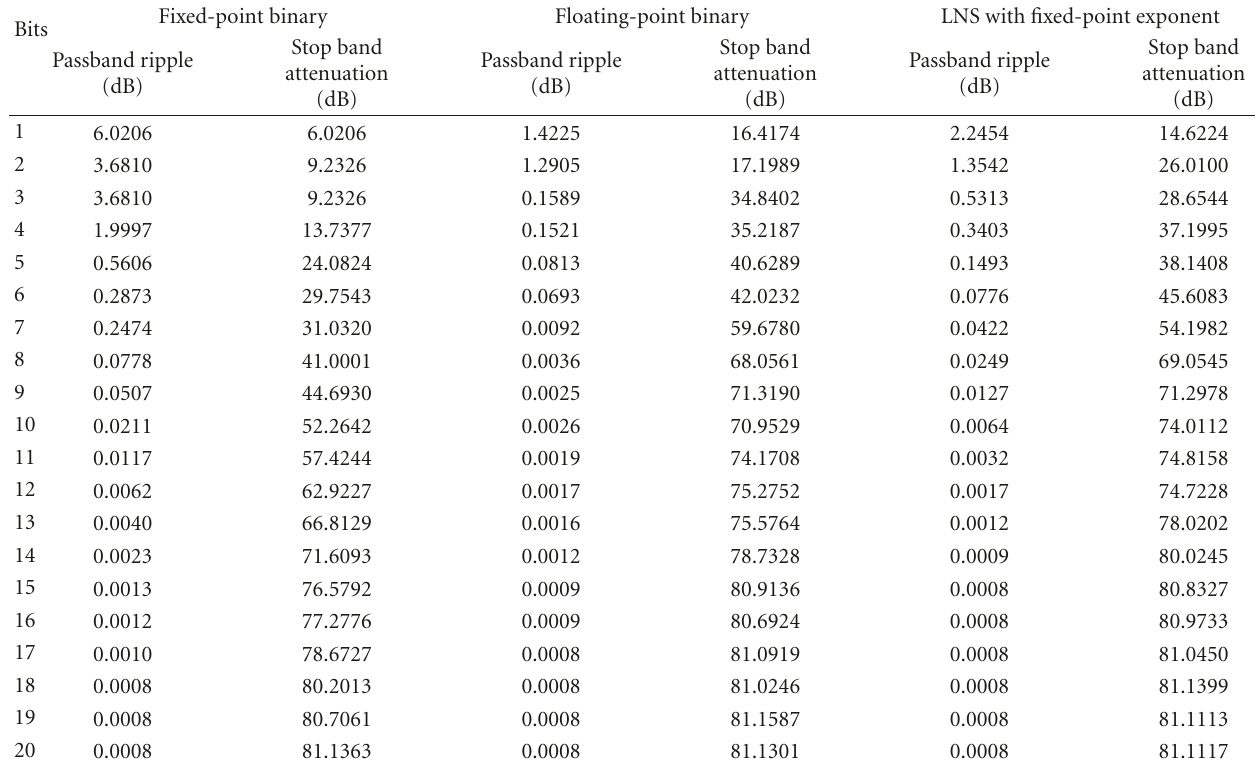
Table 8: Comparison of filter performance for general number